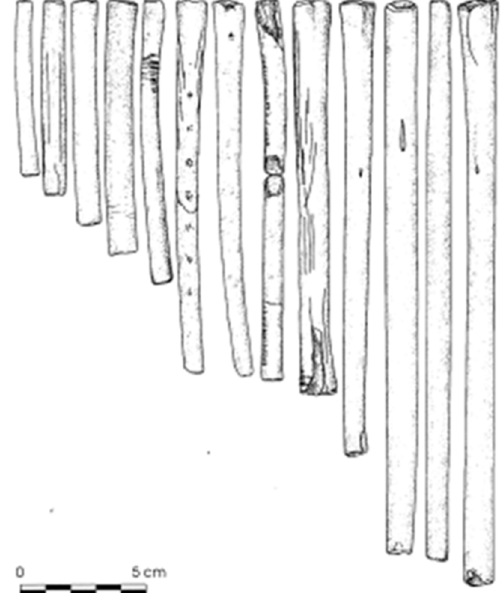
Figure 5. Entire musical tubes of the Cova de l’Or, Fountain. Source: (Martí Oliver et al. 2001, p. 58).